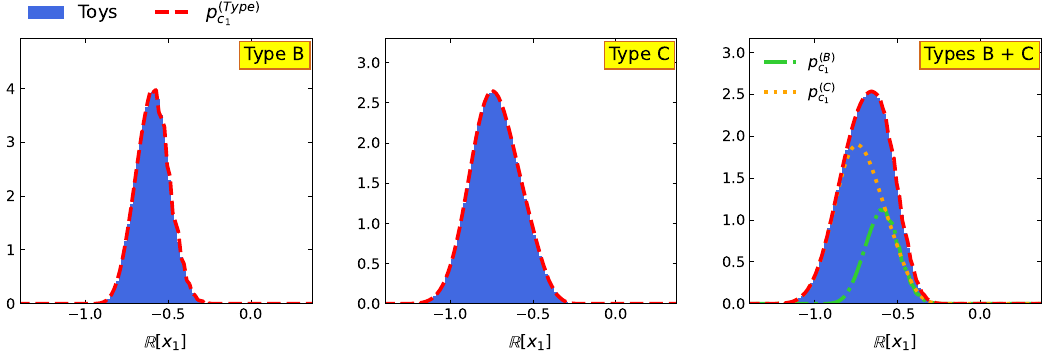
in different event categories. Type B and C events fall 1